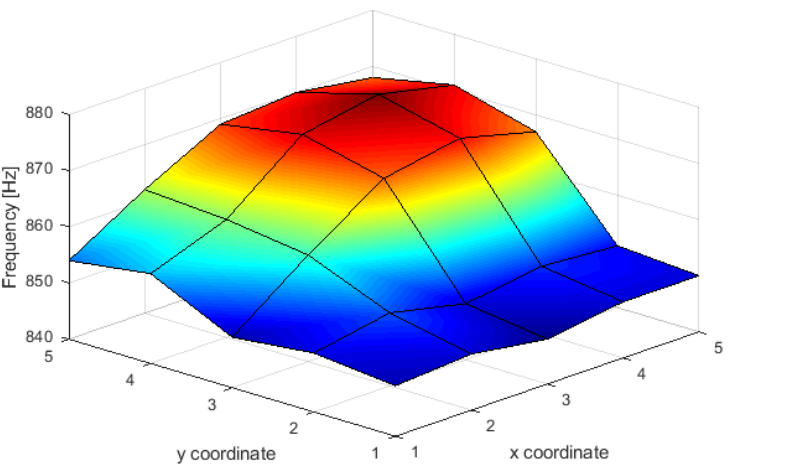
Figure 16. Frequency values in nodes with